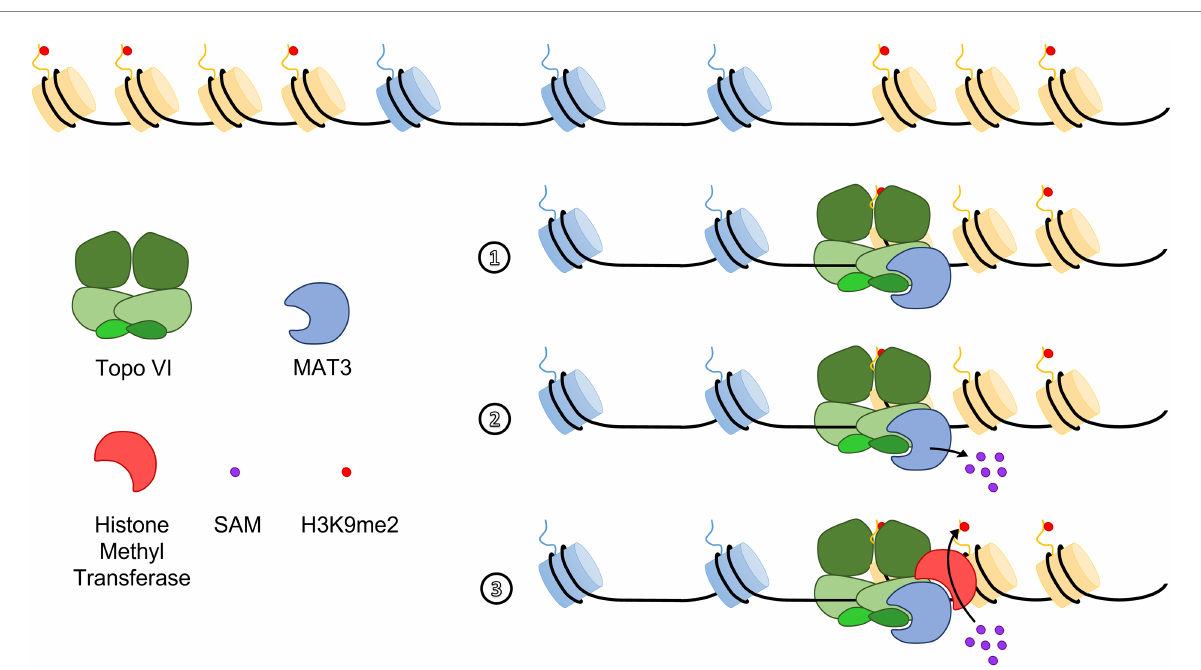
FIGURE 2 A hypothetical model for topoisomerase VI (Topo VI)-dependent insulation at Euchromatin Islands. The BIN4 subunit of Topo VI interacts with METHIONINE ADENOSYL TRANSFERASE 3 (MAT3) and is required to exclude MAT proteins from EIs (1). MAT3 localization at heterochromatin edges would allow local production of S- Adenosyl Methionine [SAM, (2)], the main methyl donor in methylation reactions, which is processed by a yet unknown histone methyltransferase to ensure in situ deposition of the repressive mark H3K9me2 in heterochromatin regions (3; Méteignier et al.,